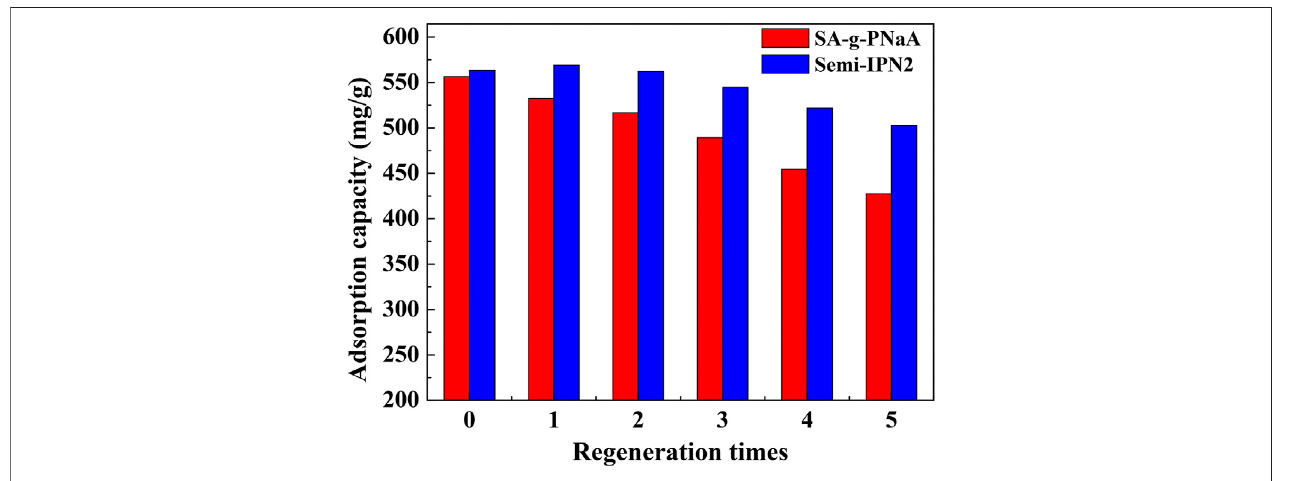
FIGURE 9 | The adsorption capacity of the SA- g -PNaA and Semi-IPN2 adsorbents towards Pb(II) after adsorption-desorption for 5 cycles.